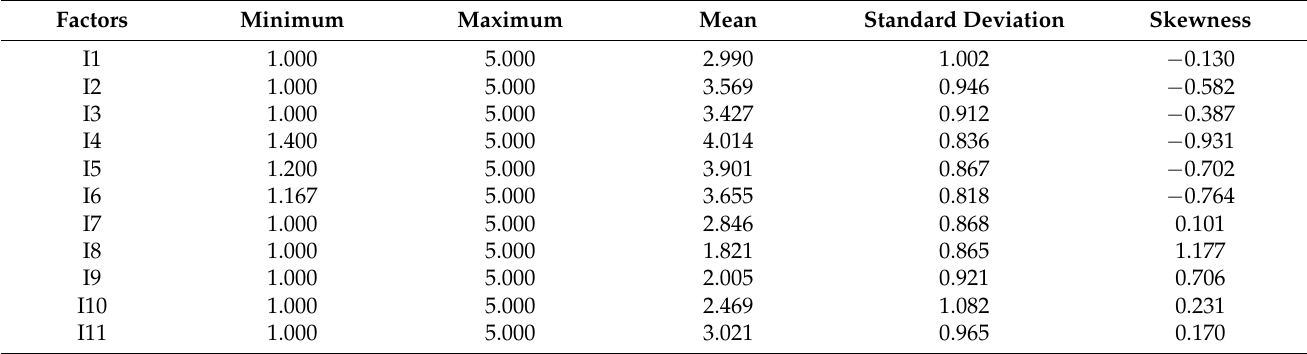
Table A4. Descriptive statistics of